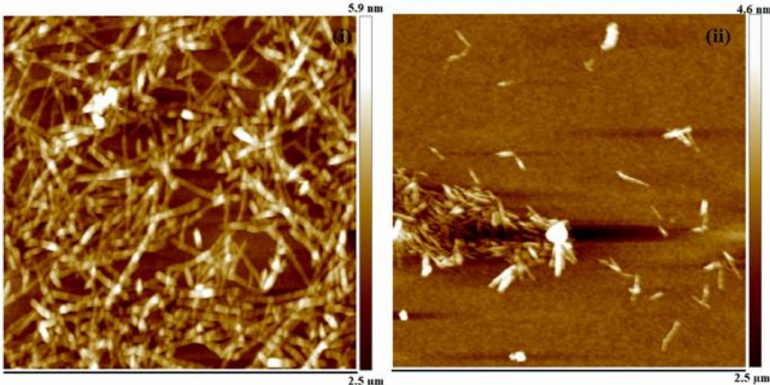
Figure 4. AFM images ( i ) 6CC and ( ii ) TCC.